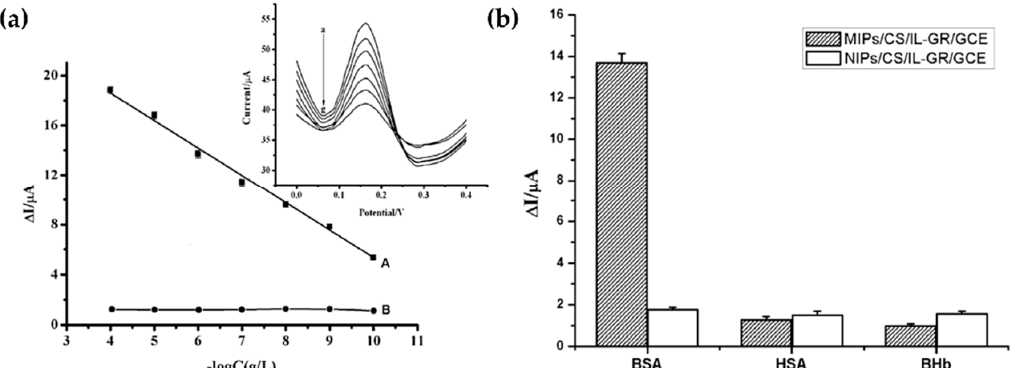
Figure 12. ( a ) Calibration curve of the prepared (A) molecularly imprinted (MIPs)/chitosan (CS)/ionic liquid–graphene (IL-GR) modified glassy carbon electrode (GCE) (MIPs / CS / IL–GR / GCE) and (B) liquid–graphene (IL-GR) modified glassy carbon electrode (GCE) (MIPs/CS/IL–GR/GCE) and (B) MIPs / CS / IL–GR / GCE for di ff erent concentrations of BSA in PBS containing 0.10-mM [Fe(CN) 6 ] MIPs/CS/IL–GR/GCE for different concentrations of BSA in PBS containing 0.10-mM [Fe(CN) 6 ] 3 − /4 − 3 − / 4 − (pH 7.0) (insert: the DPVs with di ff erent concentrations of bovine serum albumin (BSA) (pH 7.0) (insert: the DPVs with different concentrations of bovine serum albumin (BSA) on MIPs/CS/IL–GR/GCE); ( b ) selectivity of MIPs/CS/IL–GR/GCE and MIPs/CS/IL–GR/GCE for BSA, human serum albumin (HSA) and bovine hemoglobin (BHb). The concentration of each protein is 1.0 × 10 − 6 g/L. Reprinted with permission from reference [43]. Copyright © 2015 Elsevier B.V.